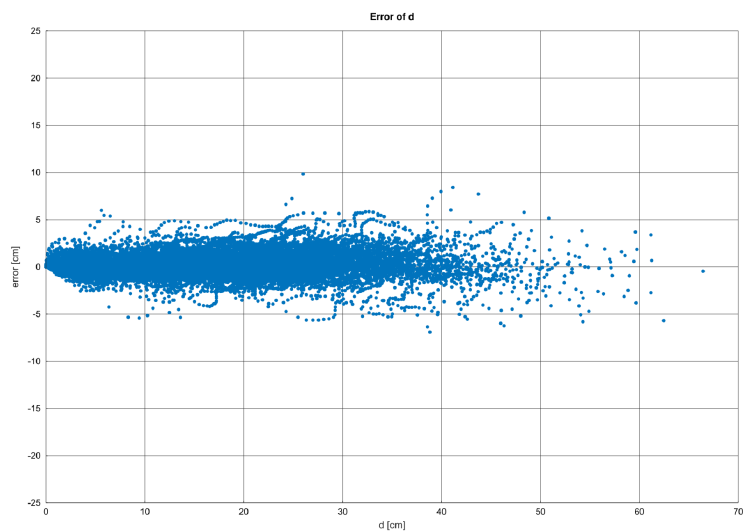
Figure 5. Residuals versus fitted values for the ANN model for pine.